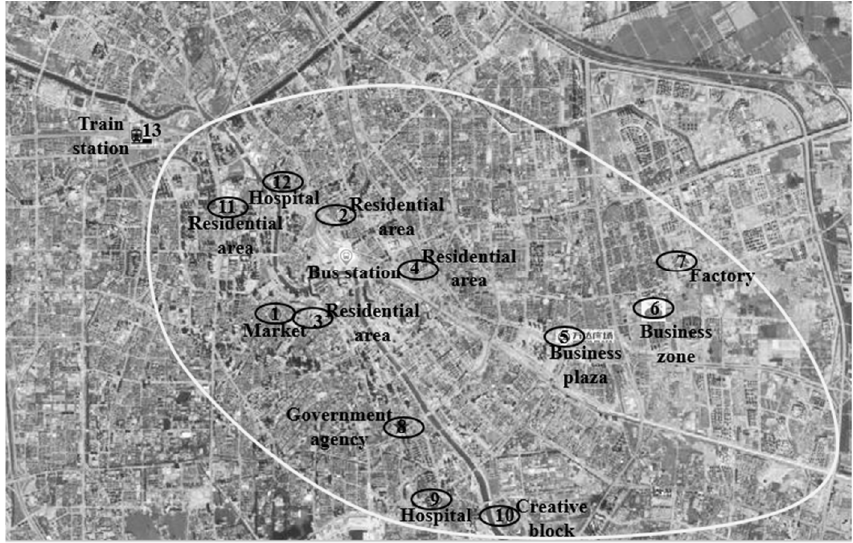
Figure 3. Results of the cluster analysis.